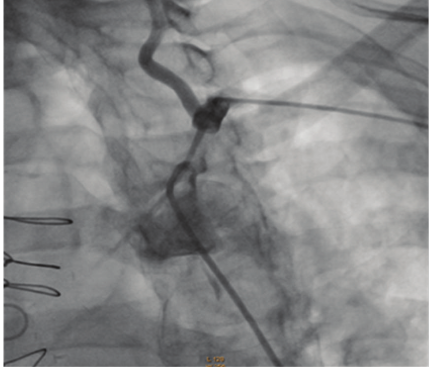
Figure 2: Absence of flow in proximal left subclavian artery with dual dye injection from catheters in aorta and left radial artery.